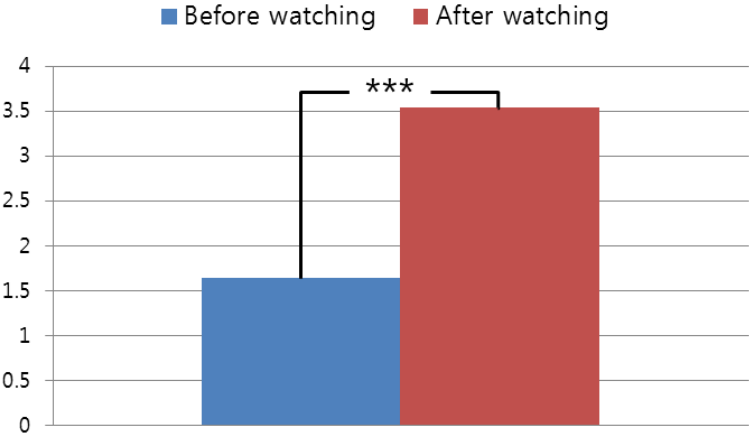
Figure 9. Result of subjective evaluation of Figure 7. (***: significant at a confidence level of p <